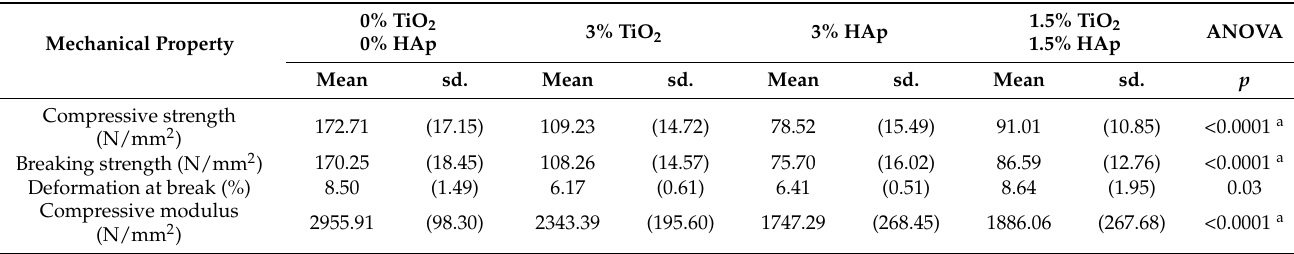
Figure 4. Compression stress–strain diagram. The mean values for the four groups of materials ( N = 6) are shown in the diagram. The control group in which Fuji IX was not modified exhibited the highest compressive stress and compressive strength. Legend: FujiIX is a control group, FujiIX3TiO 2 is material with 3% of TiO 2 , FujiIX3HAP is material with 3% HAp and FujiIX1.5TH material with 1.5% of TiO 2 and 1.5% of HAp. Table 1. Mean values and standard deviations (sd.) of compressive strength, breaking strength, deformation at break, and compressive modulus for the four Fuji IX